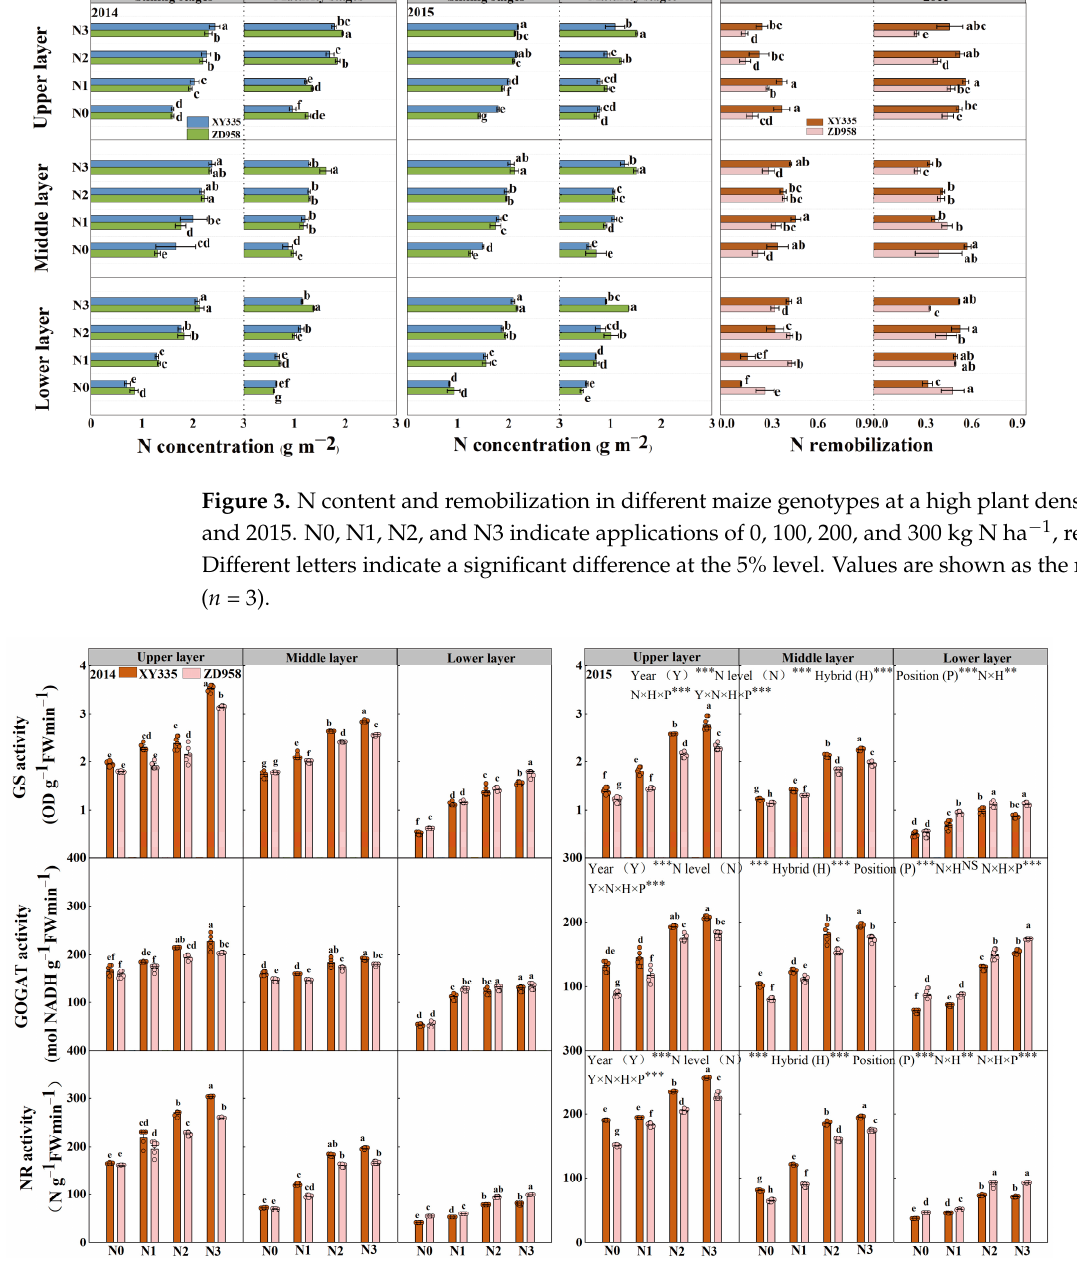
Figure 4. GS activity, GOGAT activity and NR activity of different maize genotypes at a high plant density in 2014 and 2015. N0, N1, N2, and N3 indicate applications of 0, 100, 200, and 300 kg N ha − 1 , respectively. Different letters indicate a significant difference at the 5% level. Values are shown as the mean ± SE ( n = 5). ** p < 0.01, *** p < 0.001. NS, no signi fi cance.